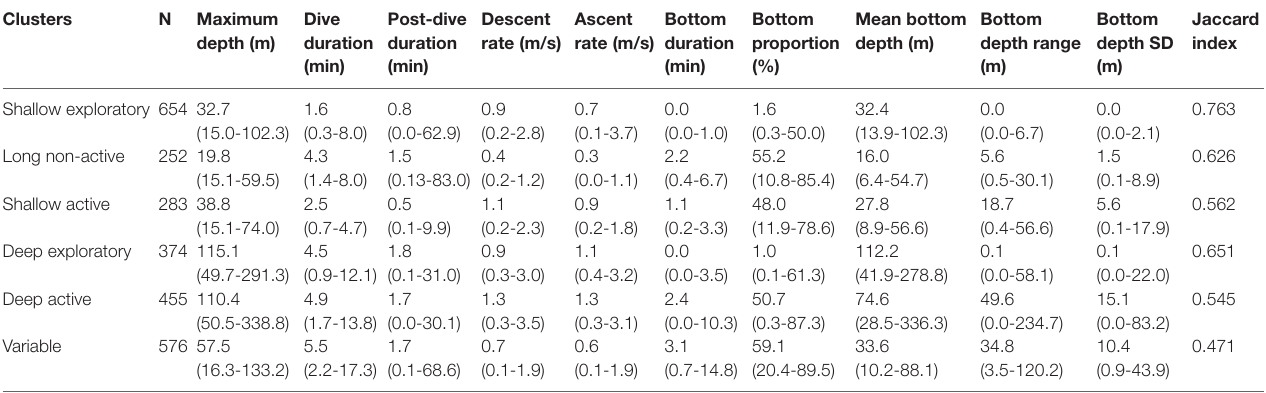
TABLE 2 | Median and range of values of each variable for the six dive types identified by the cluster analysis. Clusters